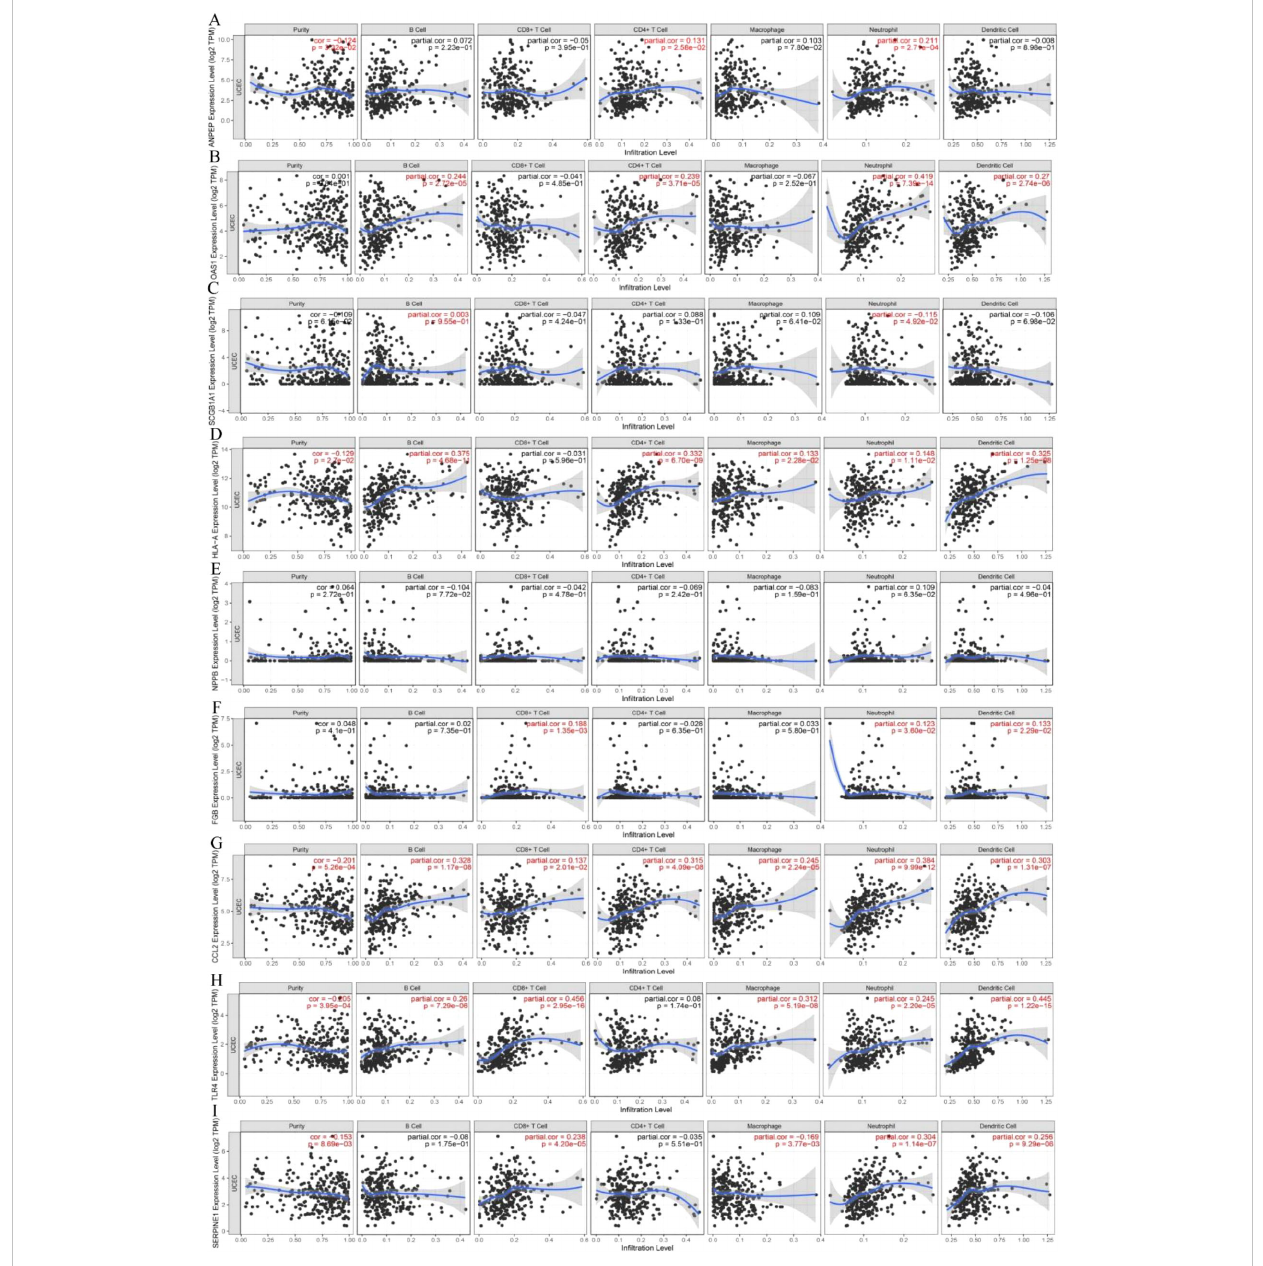
FIGURE 10 Correlation of 9 prognostic genes with immune cells in UCEC. (A) ANPEP , (B) OAS1 , (C) SCGB1A1 , (D) HLA ‐ A , (E) NPPB , (F) FGB , (G) CCL2 , (H) TLR4 , and (I) SERPINE1